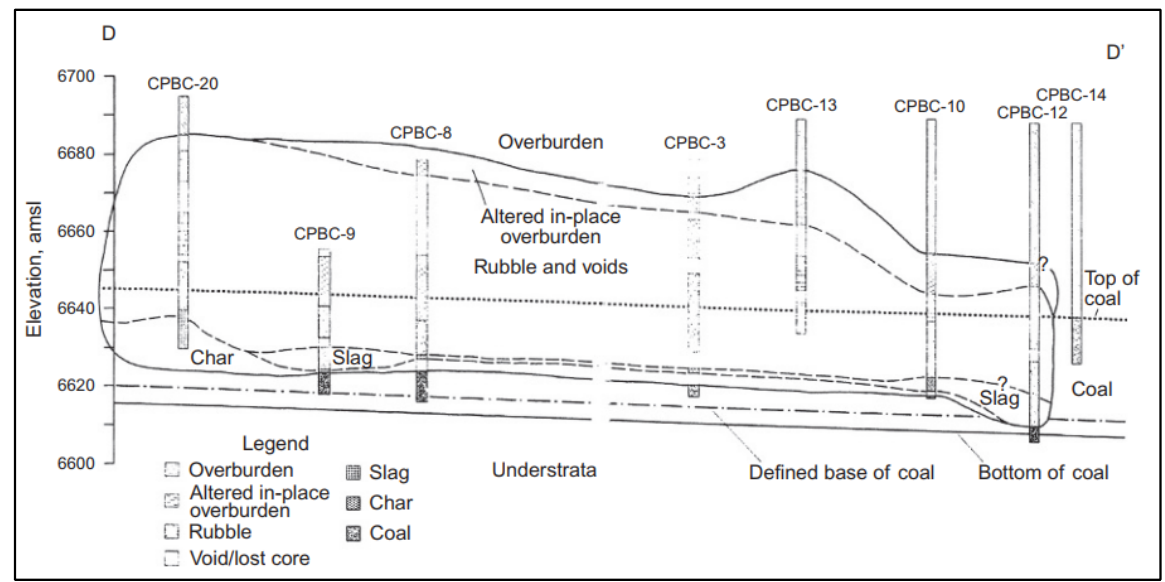
Figure 5. D-D section view of the cavity of the CRIP UCG test at Rocky Mountain I, USA (from [27]).